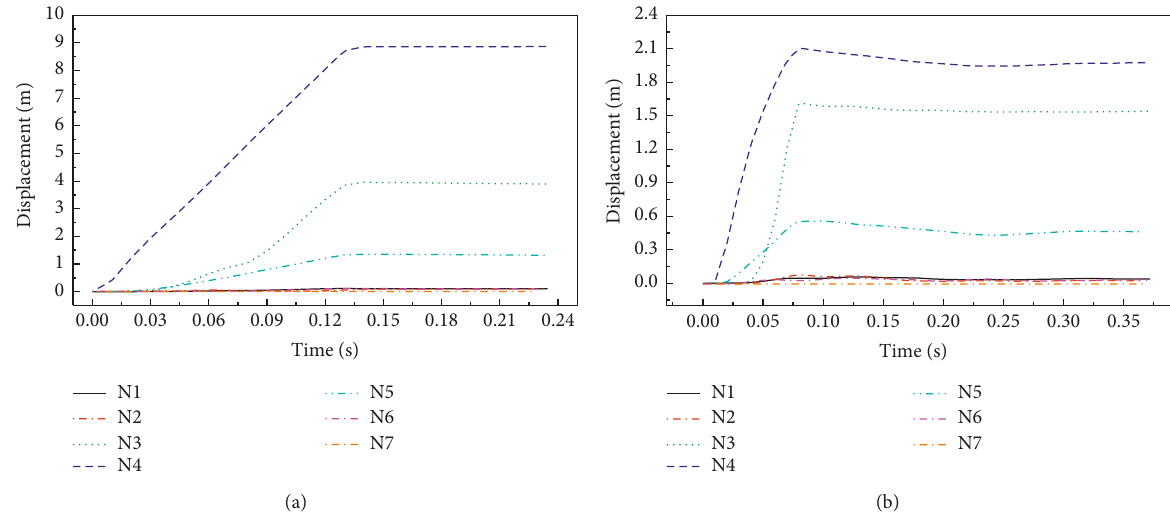
Figure 11: Displacement of ball nodes along the impact direction at 80m/s. (a) Oblique impact. (b) Lateral Table 5: Energies of the ball nodes, bars, and roof panel under oblique impact with different velocities. Velocity (m/s) Time (s) Spherical joints (MJ) Members (MJ) Roof sheathing (MJ) Ratio 0.02 0.698 80 0.01 0.999